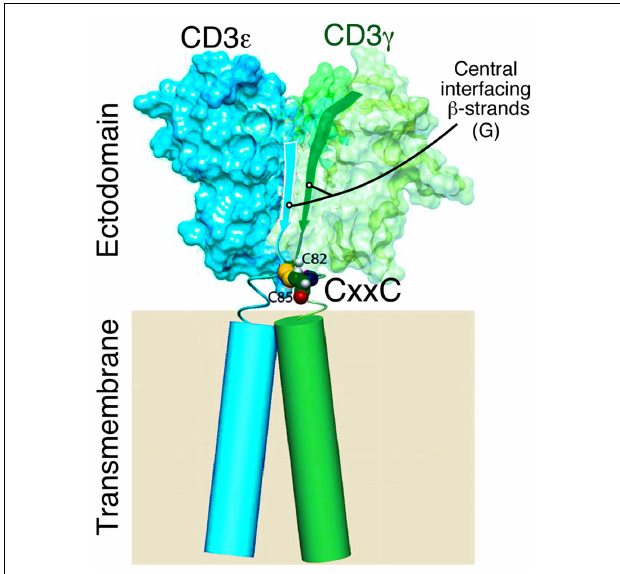
FIGURE 3 | Model of CD3 εγ heterodimer with CxxC motif proximal to TM segments. Model showing NMR-defined domains of CD3 εγ highlighting the central β strands of the ectodomain, the CxxC connecting peptide region (CD3 γ C82 and C85 cysteines only shown for clarity) and the transmembrane domains of unknown structures (cylinders) drawn to scale (Touma et al.,